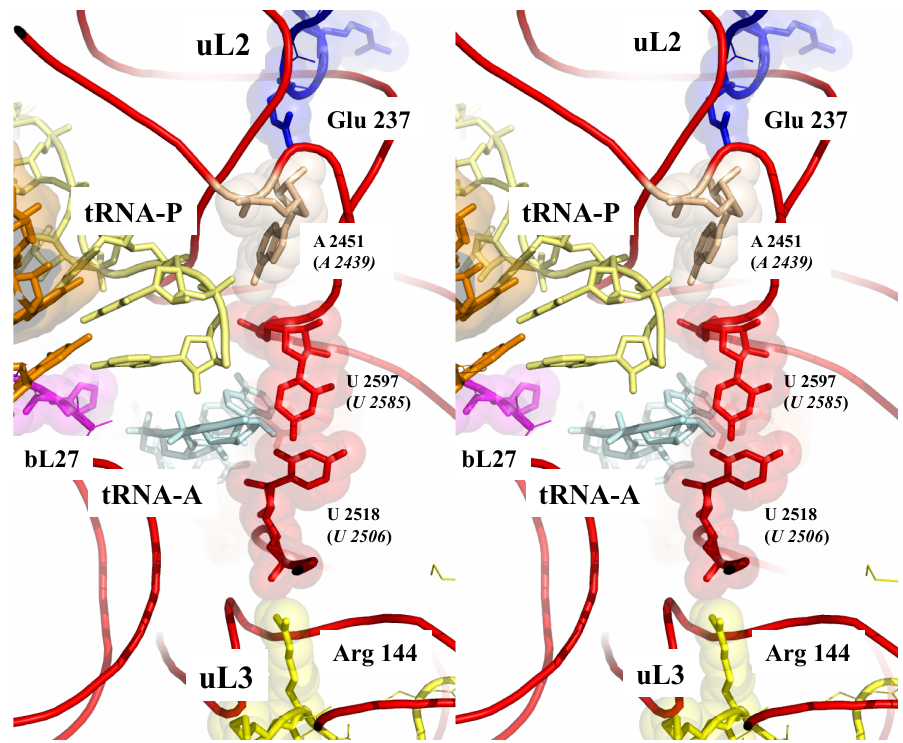
Figure 3. Sensing the peptidyl transferase centre (PTC). Stereoview of the PTC showing the pseudosymmetric interaction of uL2 (top) and uL3 (bottom) with the two uracile bases U 2585 and U 2518 (E. coli numbering) that undergo conformational changes upon tRNA binding. The backbones of the PTC rRNA helices are represented by red cartoons (pdb_id: 4y4p).